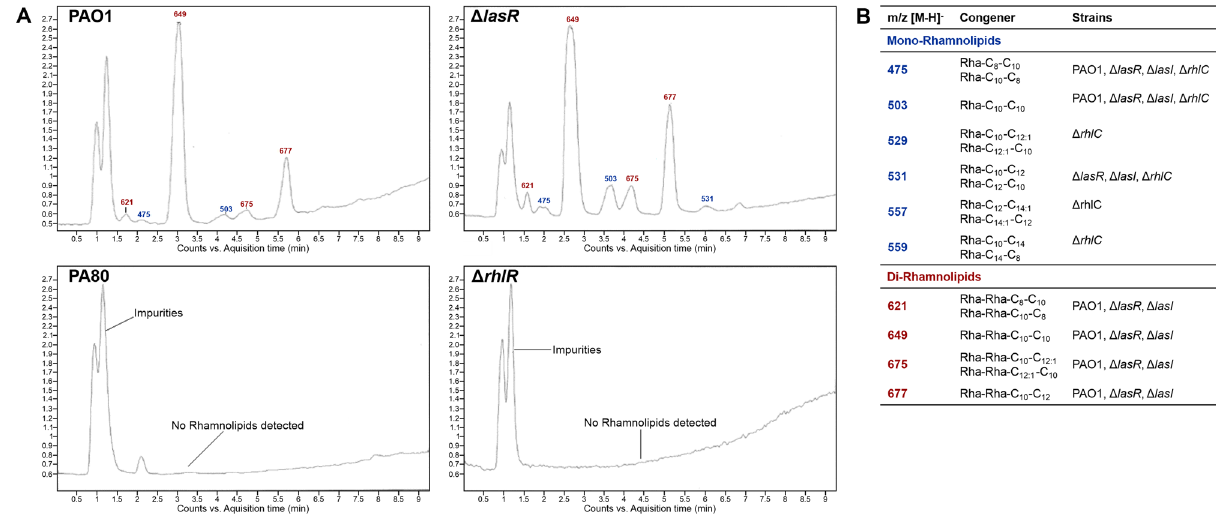
Figure 7. PA80 does not produce rhamnolipids. ( A ) HPLC–MS chromatogram of rhamnolipids (RLs) detected in PAO1, ΔlasR, ΔrhlR and PA80. Rhamnolipids are produced independent of lasR but it is essential to have a functional rhlR present. PA80 lacking rhlR does not produces RLs. ( B ) Comparison of the RLs congeners produced in wild-type PAO1 and mutant strains. ΔlasR produces RLs congeners in the same composition as